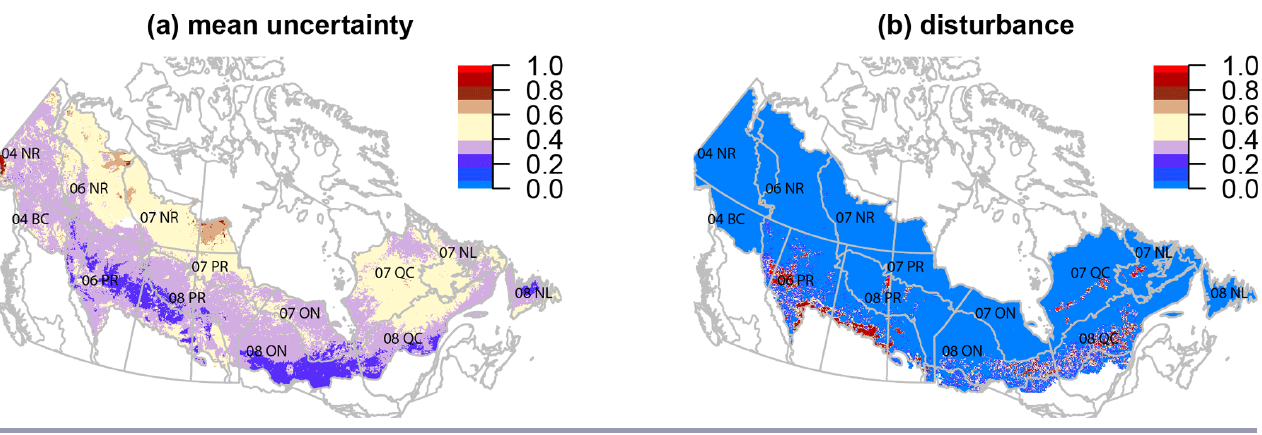
Fig. 3 . Combined disturbance and uncertainty discounting maps. (a) Mean uncertainty, i.e., coefficient of variation of density estimates averaged across 63 species (illustrative only; individual species’ standard deviation layers used in analysis); (b) current anthropogenic disturbance proportion.